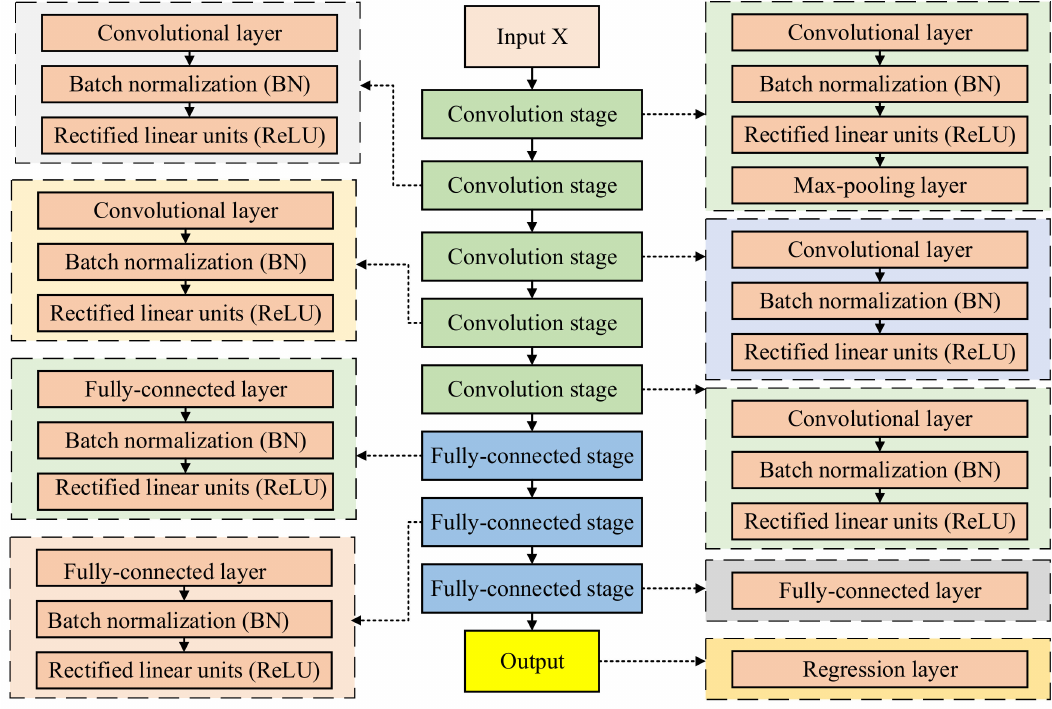
Figure 7. The one-step iterative framework of the DCNN-TL